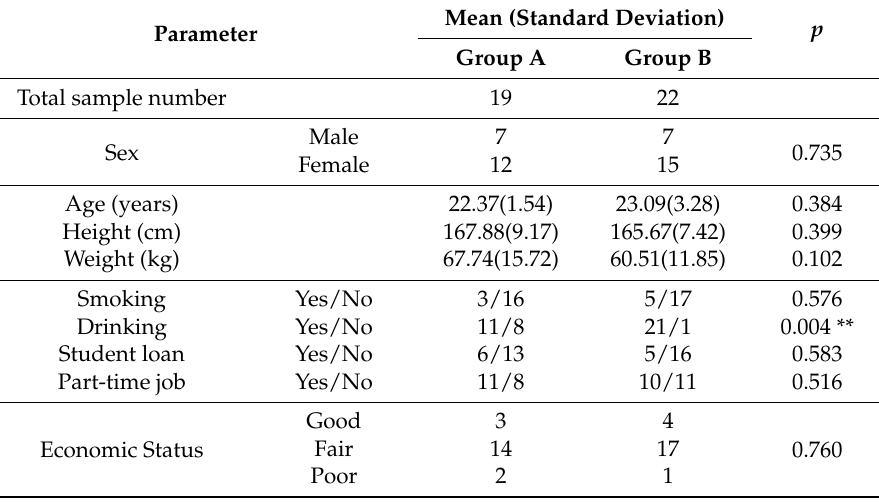
Table 1. Demographic characteristics of the experimental groups.